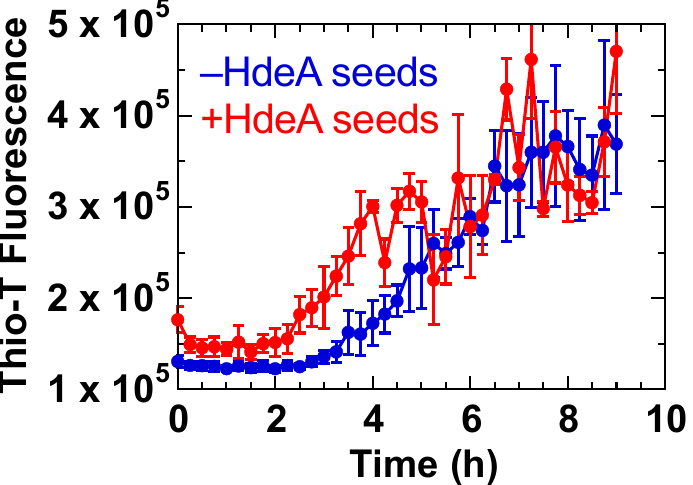
Figure 8. Preformed seeds of HdeA promote the fibrillation of HdeB at pH 2. Mixing a 1/100 (by mass) aliquot of preformed HdeA fibril sample to soluble HdeB at pH 2 resulted in a shortened lag phase during the fibril forming reaction of the latter protein, indicating a heterogeneous stimulating effect by HdeA seeds on HdeB fibrillation. Since HdeA and HdeB are both susceptible to forming fibrils under these conditions, these examples of “cross-seeding” events suggest implications that are relevant to the actual conditions inside the E. coli periplasm.